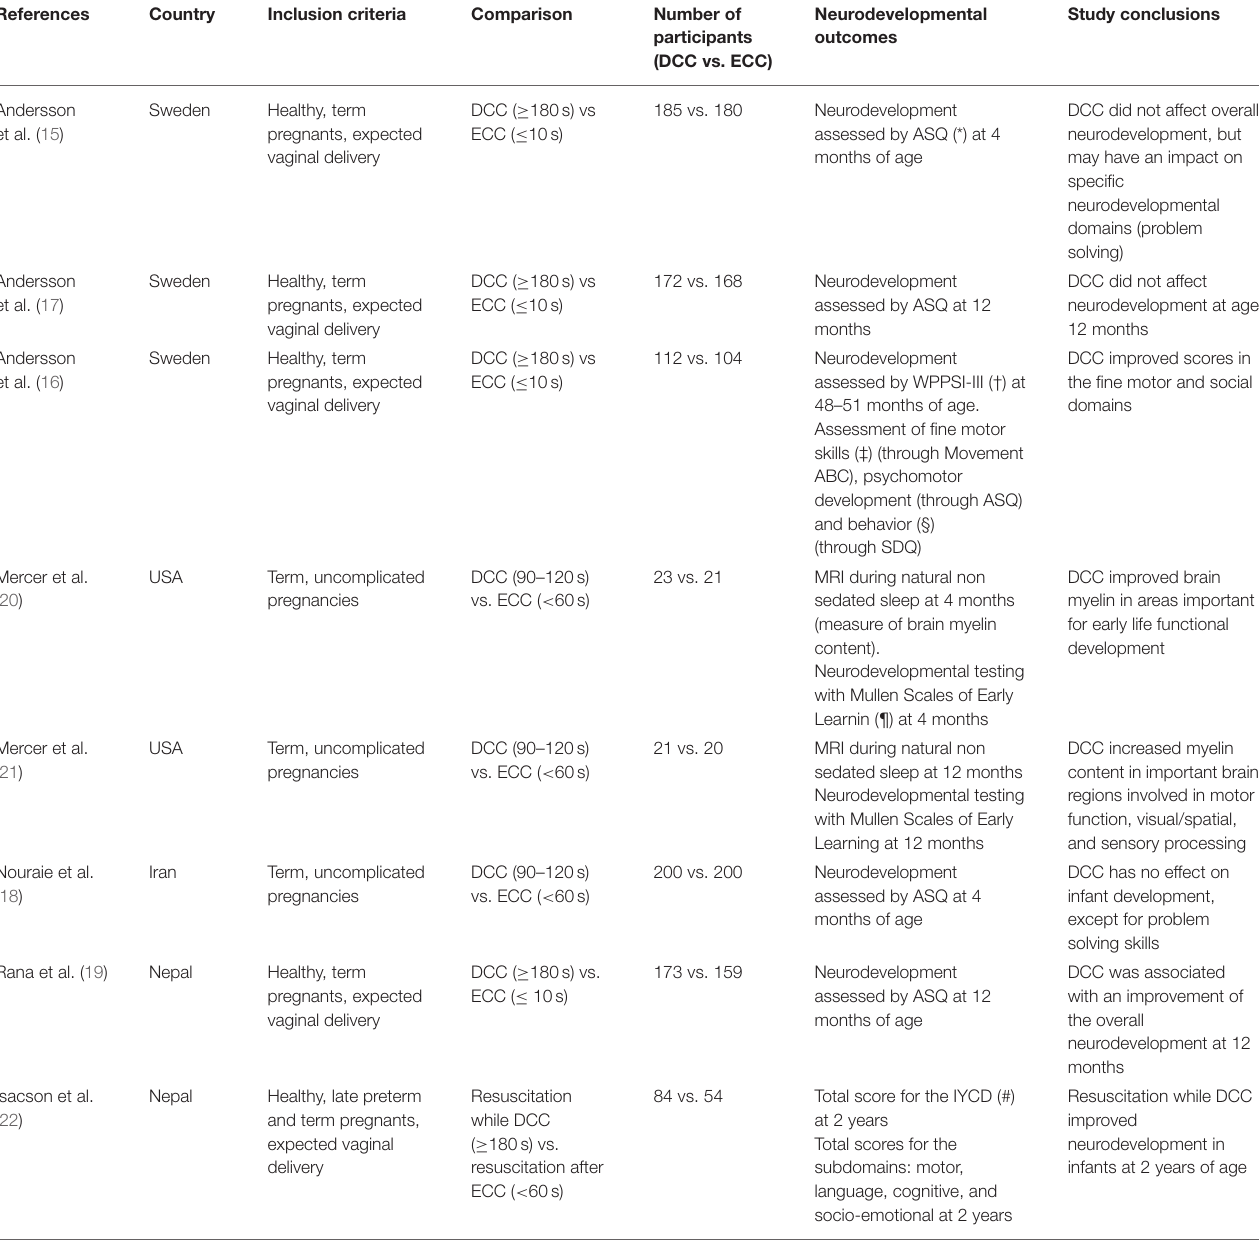
TABLE 1 | Description of the included studies in the qualitative